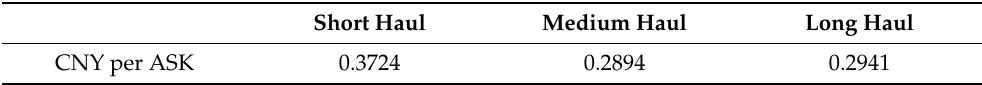
Table 2. Cost per available seat